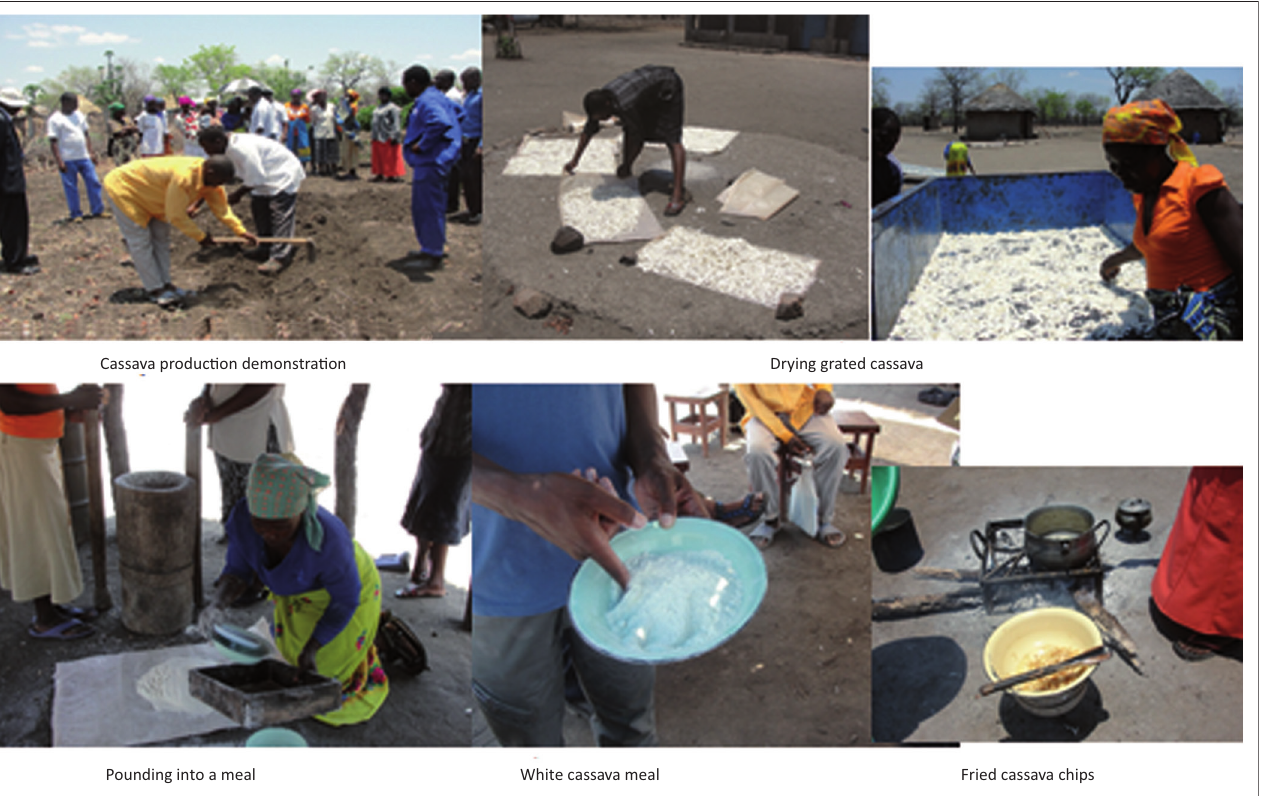
FIGURE 10: Cultivation and processing of cassava.